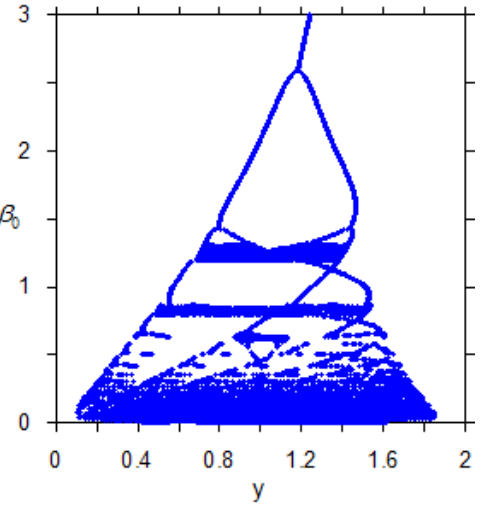
Fig. 5. Bifurcation diagram demonstrating modes of behavior of the system of Eq. (10).